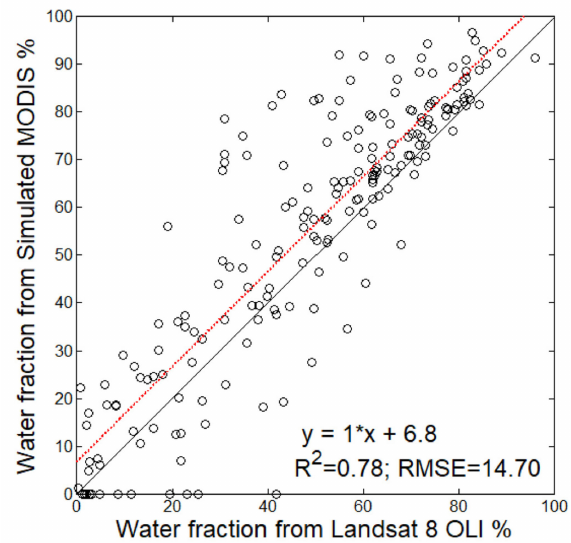
Figure 5. Comparison of the water fraction retrieved from simulated MODIS data versus the reference OLI water fraction at the Ngoring Lake boundary. The dashed line is the linear regression